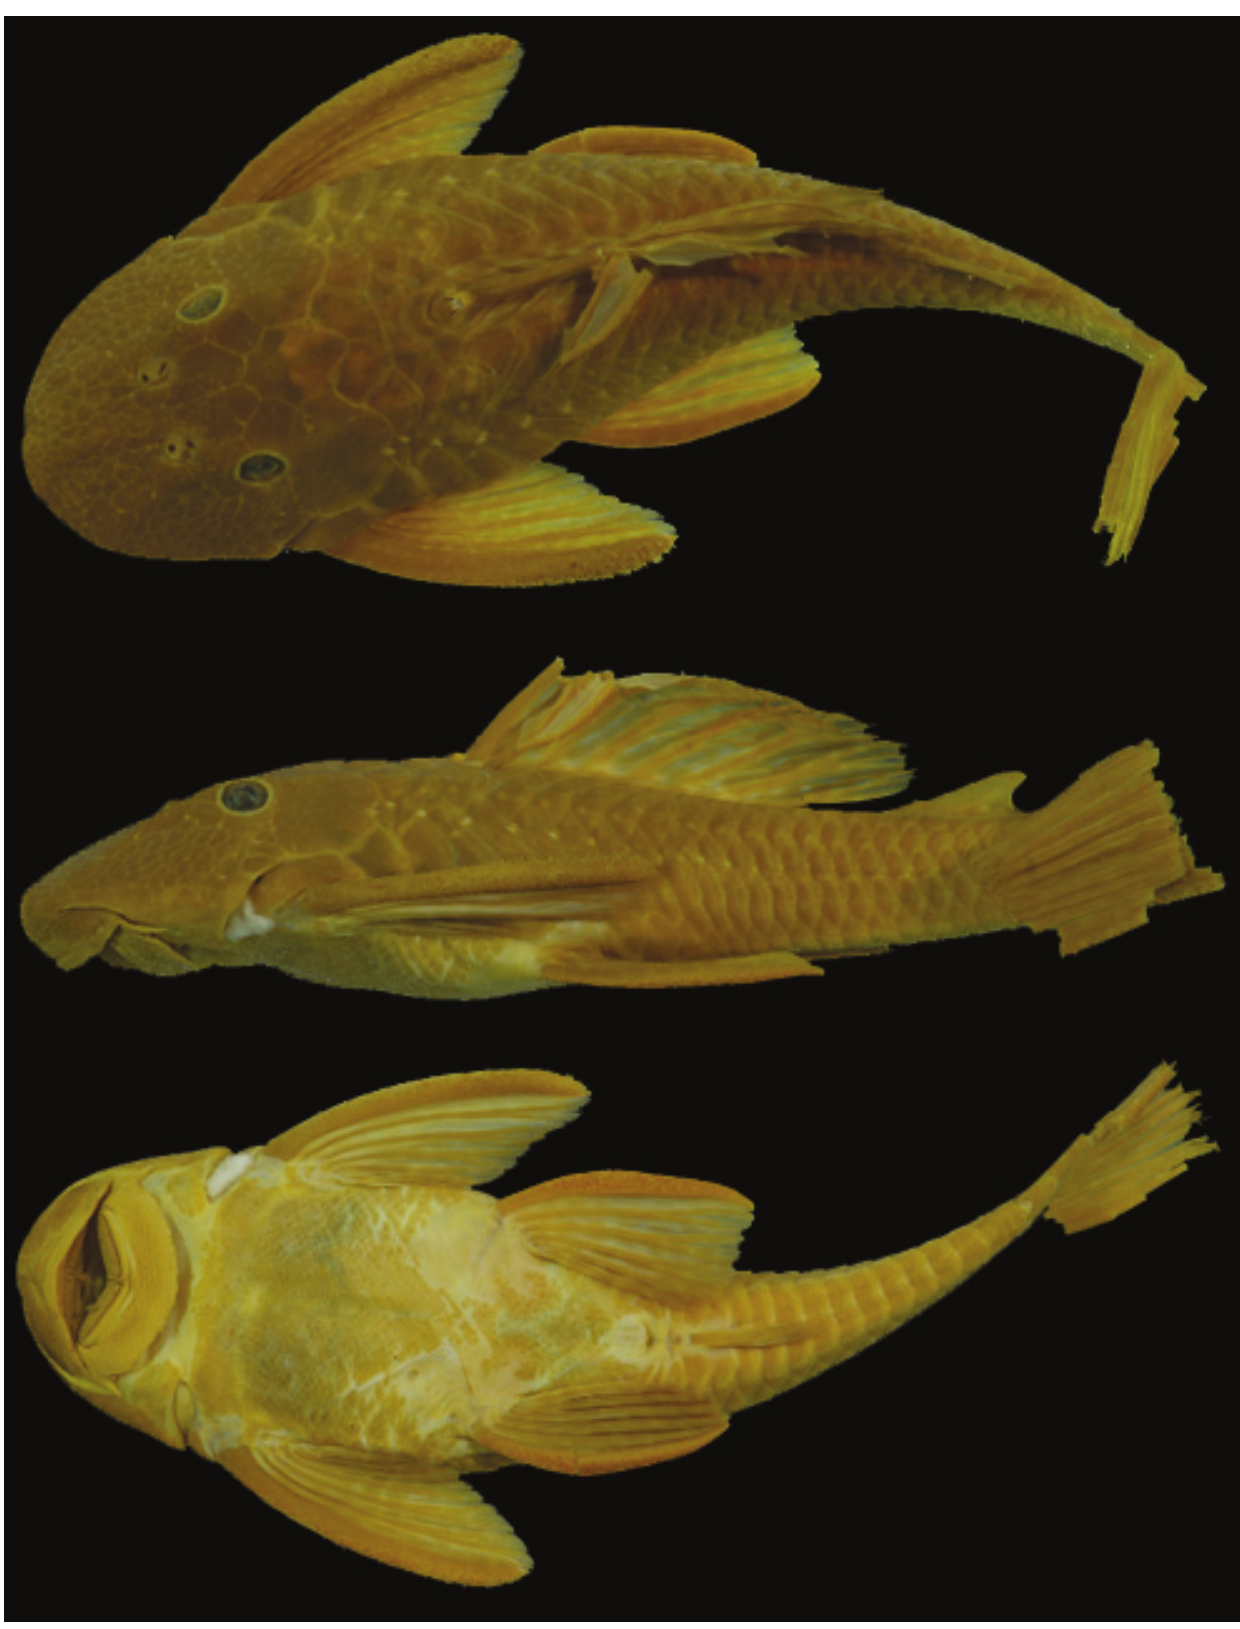
Fig. 5. Holotype of Hypostomus myersi MNRJ 4251, 174.0 mm SL, Porto União, rio Iguaçu, Paraná,